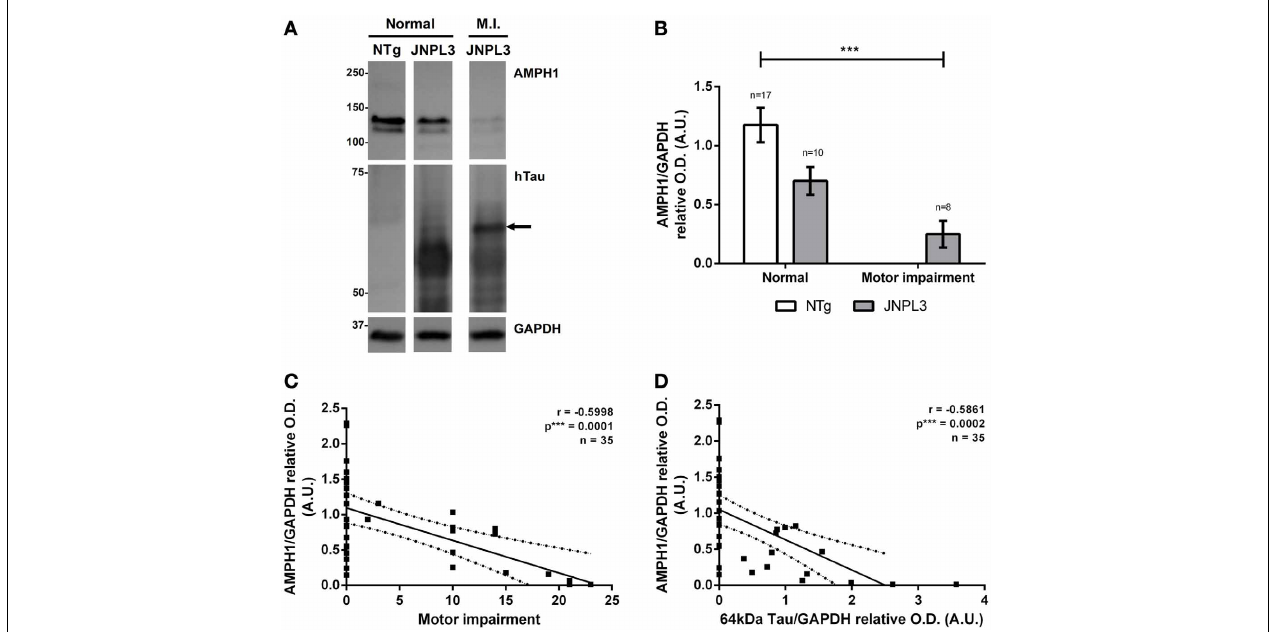
FIGURE 2 | AMPH1 protein depletion is associated with pathological events in tau-mediated neurodegeneration. (A) When compared to NTg controls, JNPL3 mice with impaired motor function show reduced levels of the protein AMPH1 in the spinal cord, as illustrated by immunoblots. The protein level reduction is accompanied by the accumulation of 64kDa hyperphosphorylated hTauP301L. Arrow indicates tau positive bands with a 63.2kDa molecular weight according to linear semi-logarithmic